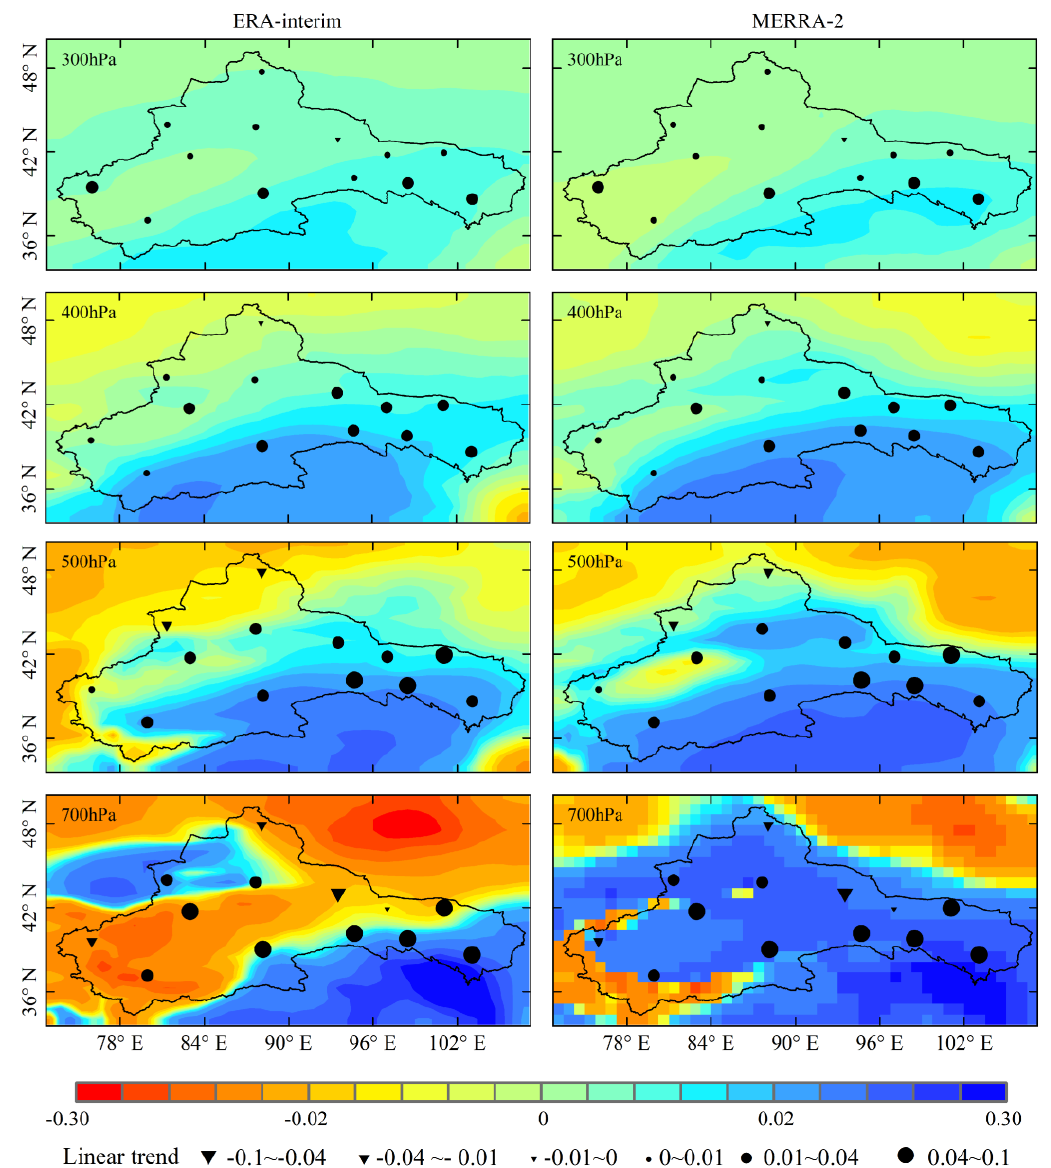
Figure 8. Spatial distribution of the trends of specific humidity from different atmospheric levels during the period 1980– 2018 (g/(kg·10a)).